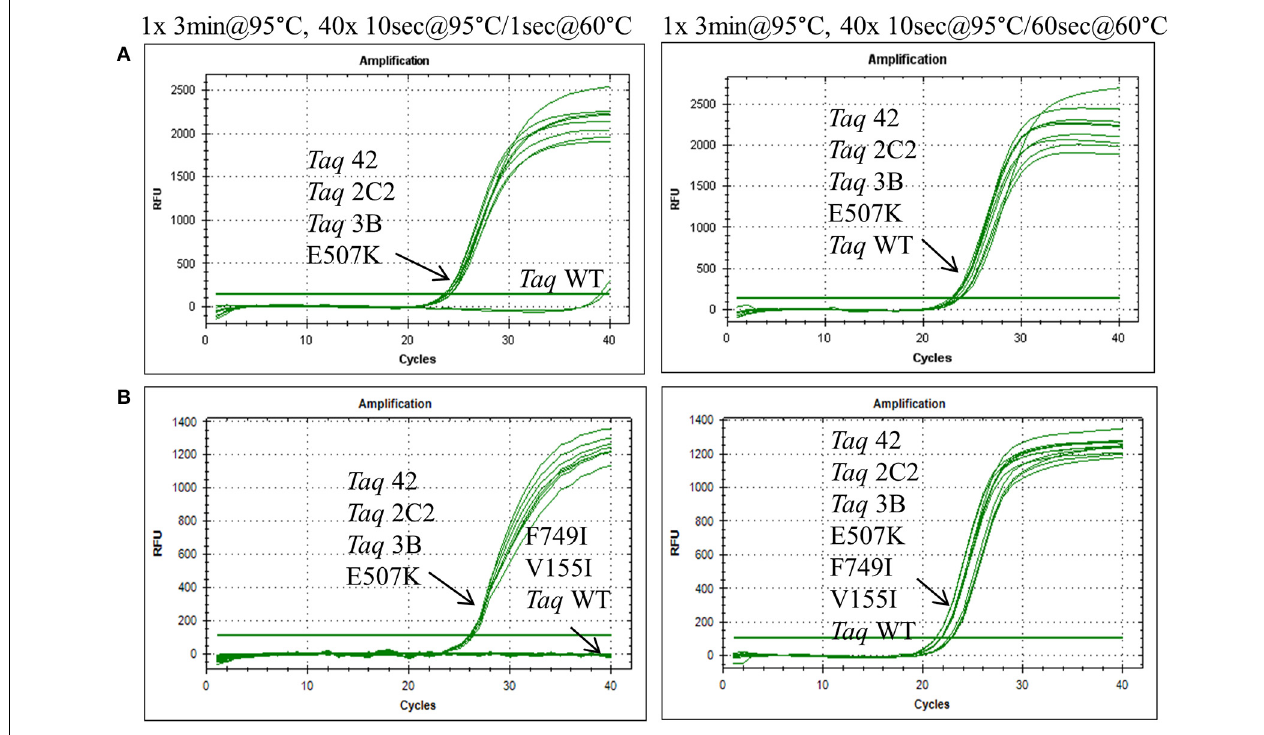
FIGURE 1 | Fast cycling conferred by E507K mutation. Genomic DNA targets were amplified as described in Methods using 10ng human gDNA and 20ng of purified wild-type or mutant Taq DNA polymerase. Reactions were cycled on the CFX96 instrument (BioRad)